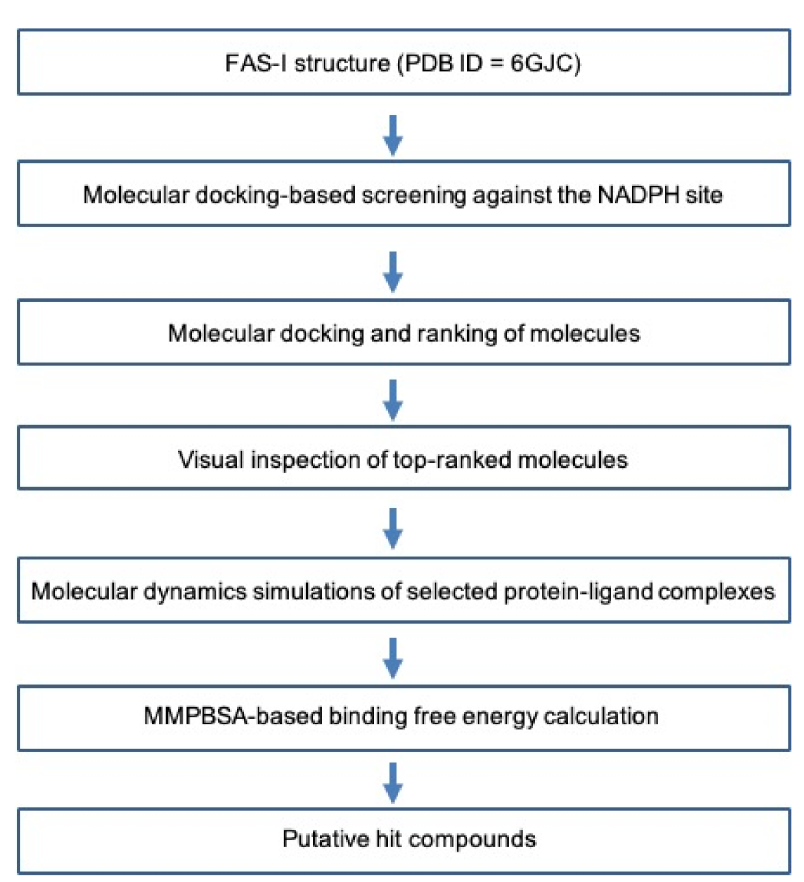
Figure 2. The work plan for molecular docking-based virtual